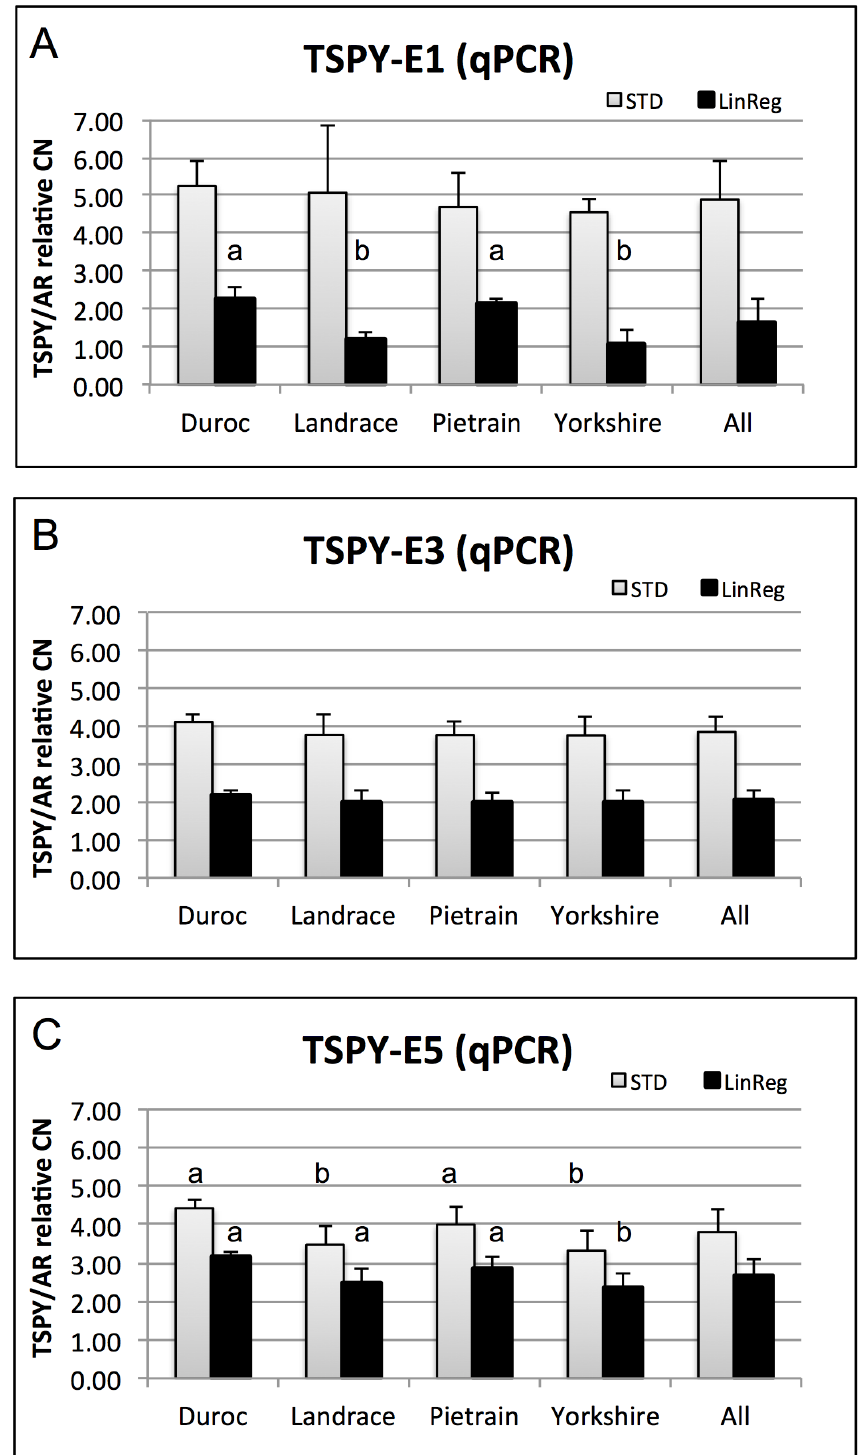
Fig 2. TSPY CN relative to the single copy AR gene, as determined by qPCR. CN was measured at three loci (Exon 1, 3, 5) in four breeds. Columns represent the average value ( ± SD) of 5 animals from the same breed. Different letters within efficiency calculation methods (STD or LinRegPCR) represent statistical significance according to two-way ANOVA (p < 0.05).